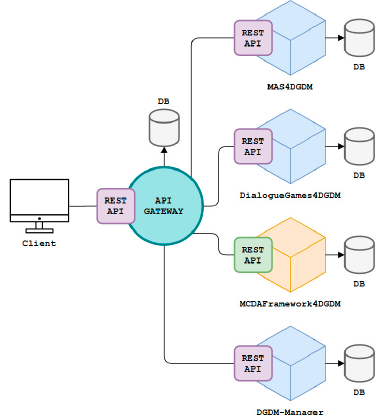
Figure 1. Consensus-Based Group Decision Support System Architecture (adapted from [40]).